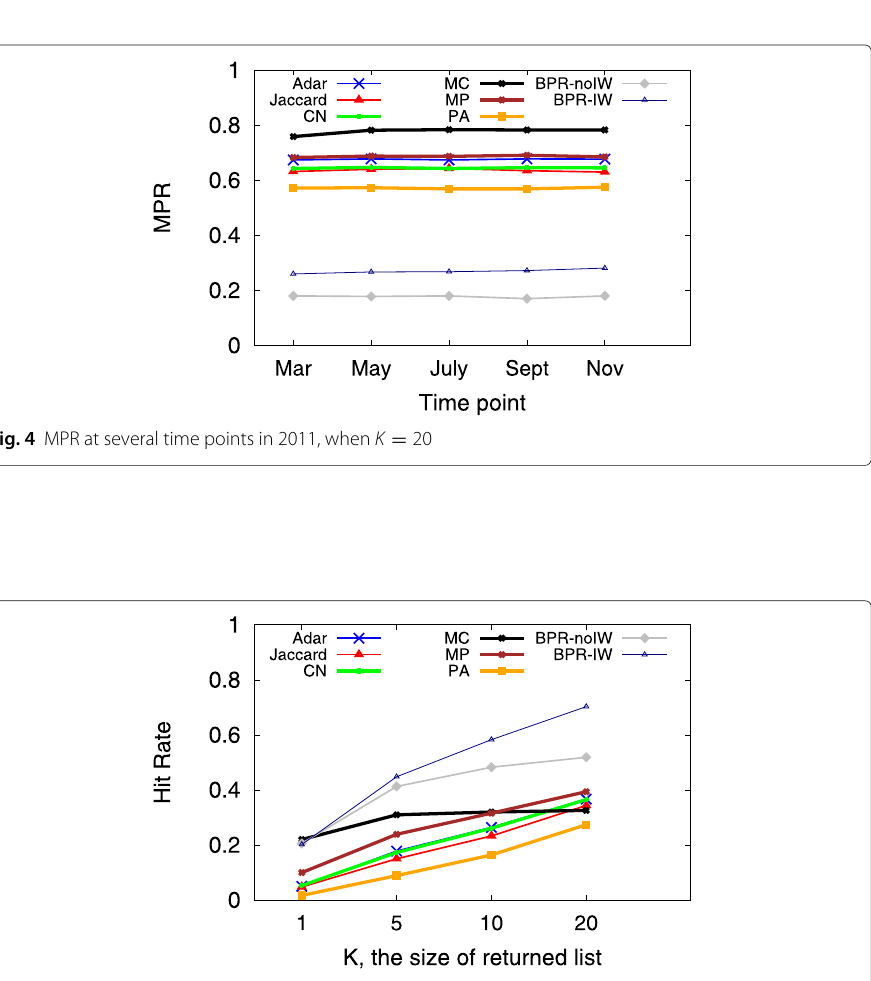
Fig. 5 HR with different K on 07/01/2011